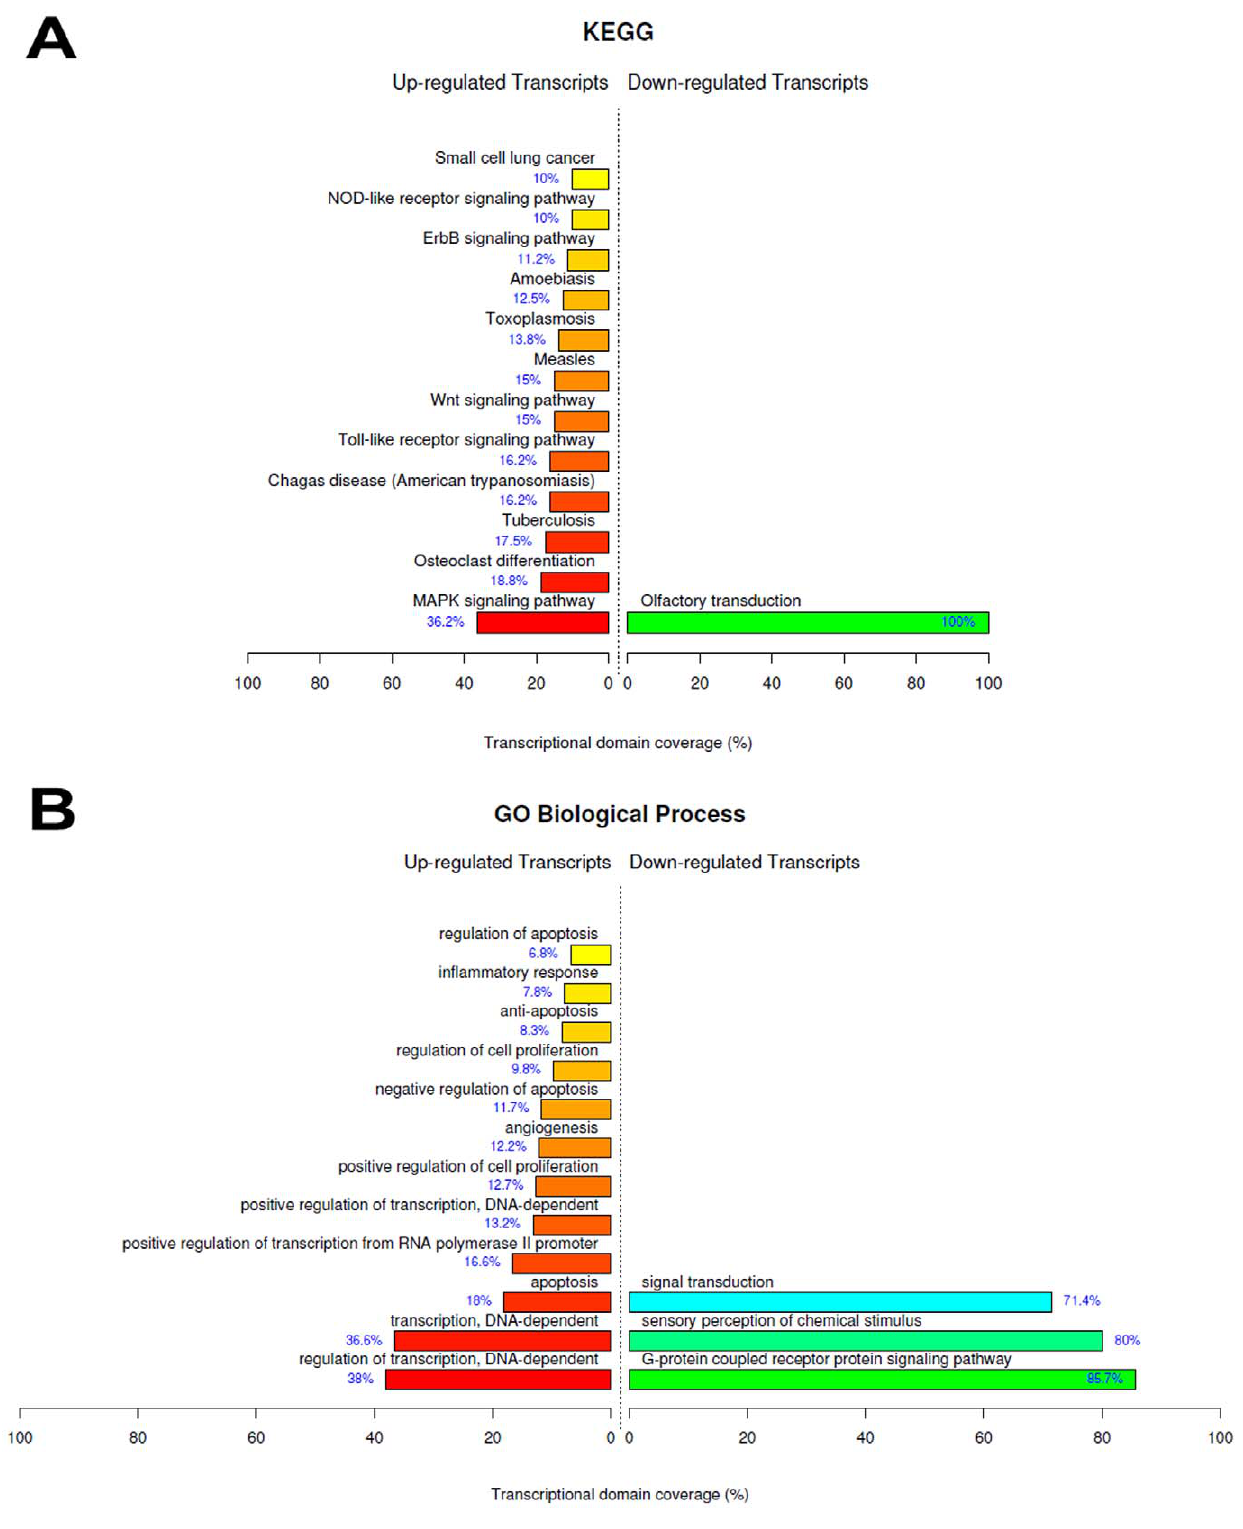
Figure 4. Top ranked biological functions after renal ischemic pre-conditioning and ischemia/reperfusion injury. A) KEGG categories showing significant enriched functions for differentially expressed genes at IPC + IRI vs Control comparison; B) Biological Process Ontology (GO) of the differentially expressed genes at IPC + IRI vs Control comparison. The bar plot represents the percentage of genes differentially expressed and functionally annotated in isolated kidney tissue. Bar plot colors represent up (red) and down (green) regulated genes.